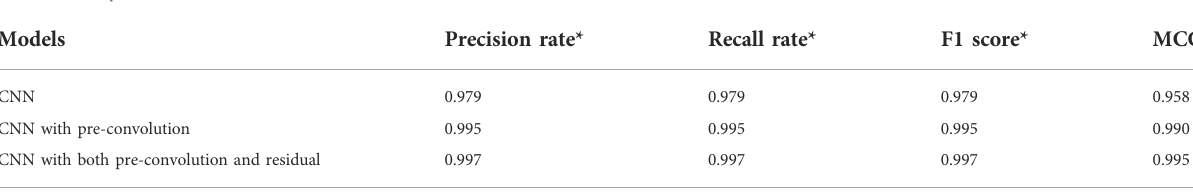
TABLE 1 Comparison of model